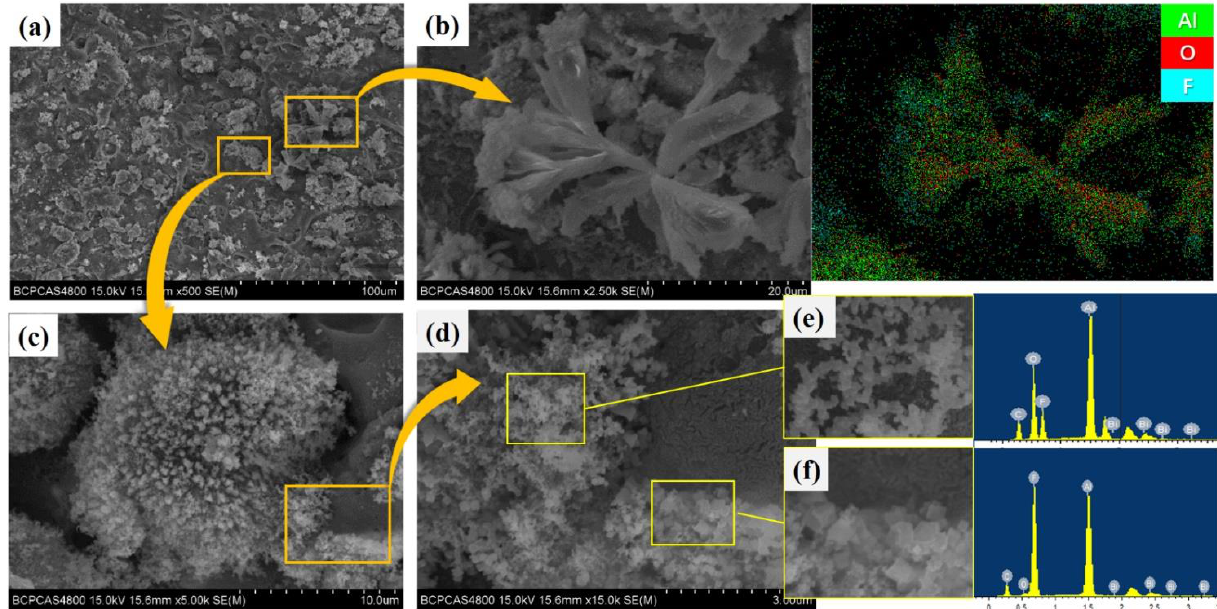
Figure 17. SEM photograph of reaction remnant: ( a ) Al protrusion embedded in the matrix at the reaction interface; ( b ) ruptured Al 2 O 3 shell; ( c ) reaction products on the surface of Al particles; ( d ) reaction products; ( e ) Al 2 O 3 smoke; ( f ) AlF 3 crystal products.